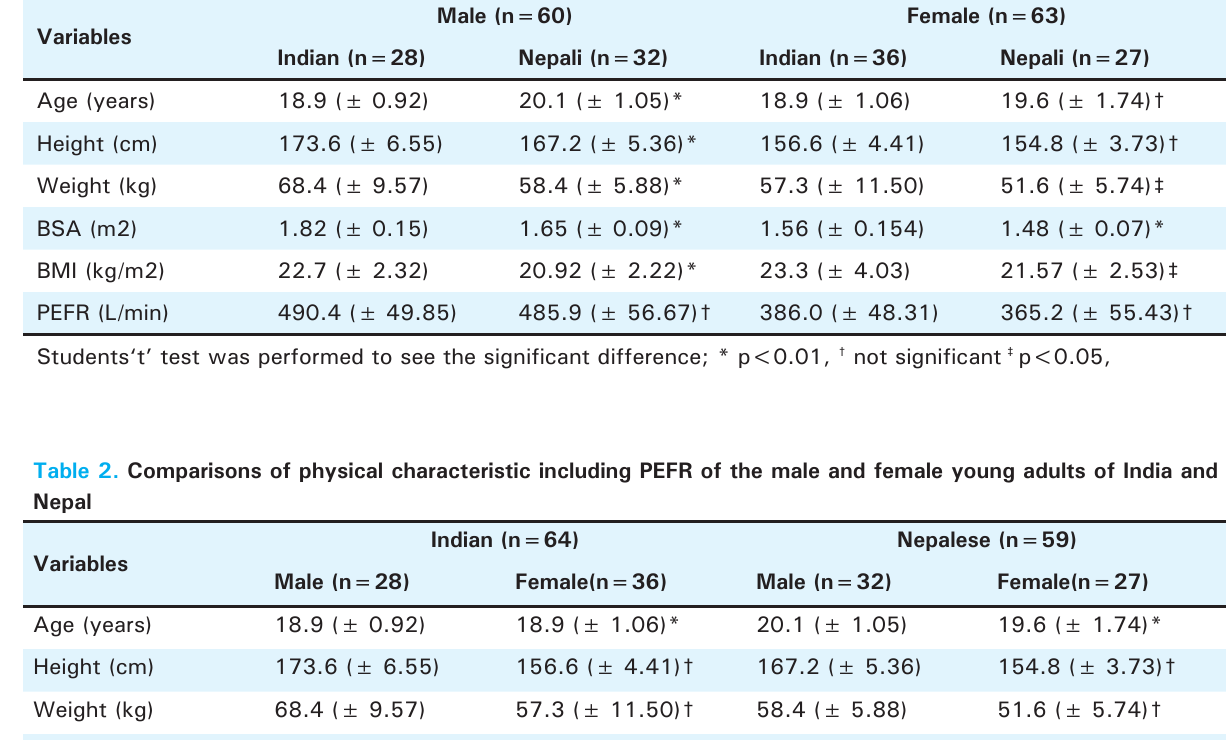
Table 1. Comparisons of physical characteristics including PEFR of the Indian and Nepalese young adults